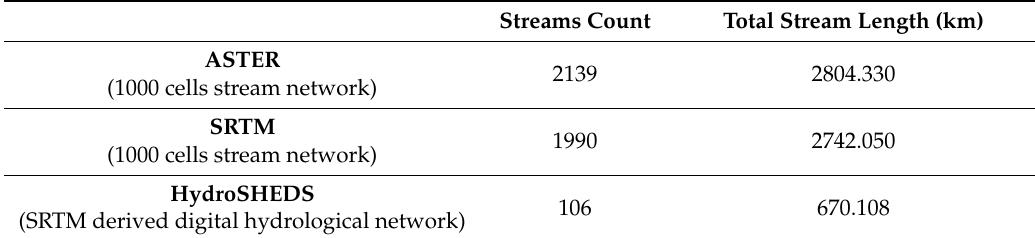
Table 3. Comparison of the extracted hydrological data using different datasets in this study (ASTER, SRTM), with existing data